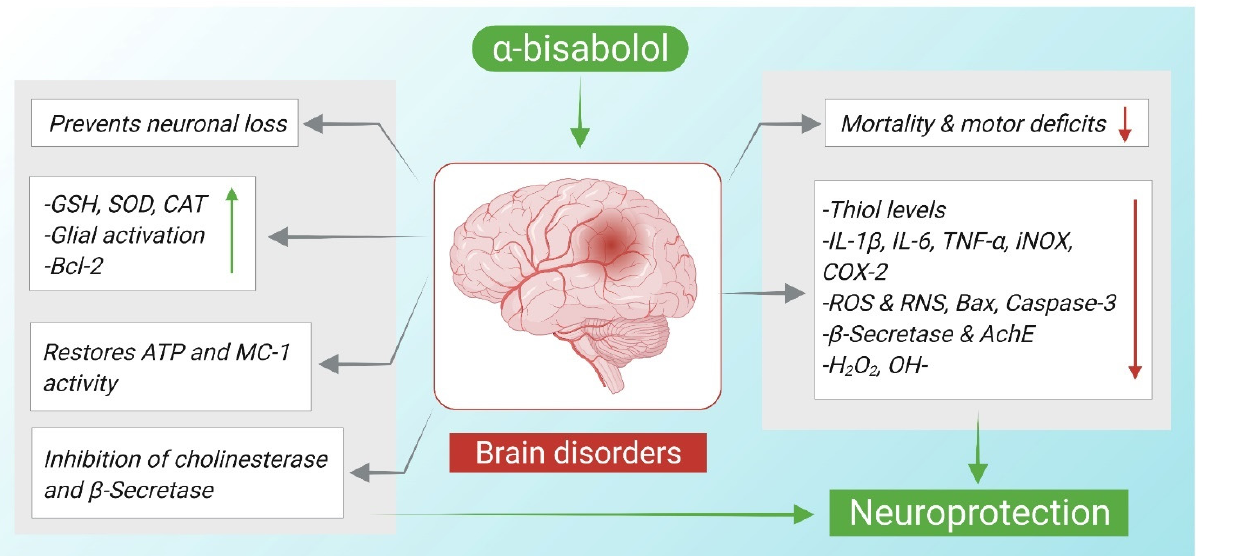
Figure 2. Neuroprotective mechanisms of α‐ Bisabolol against neurodegeneration.  ; increase,  ;de ‐ crease.